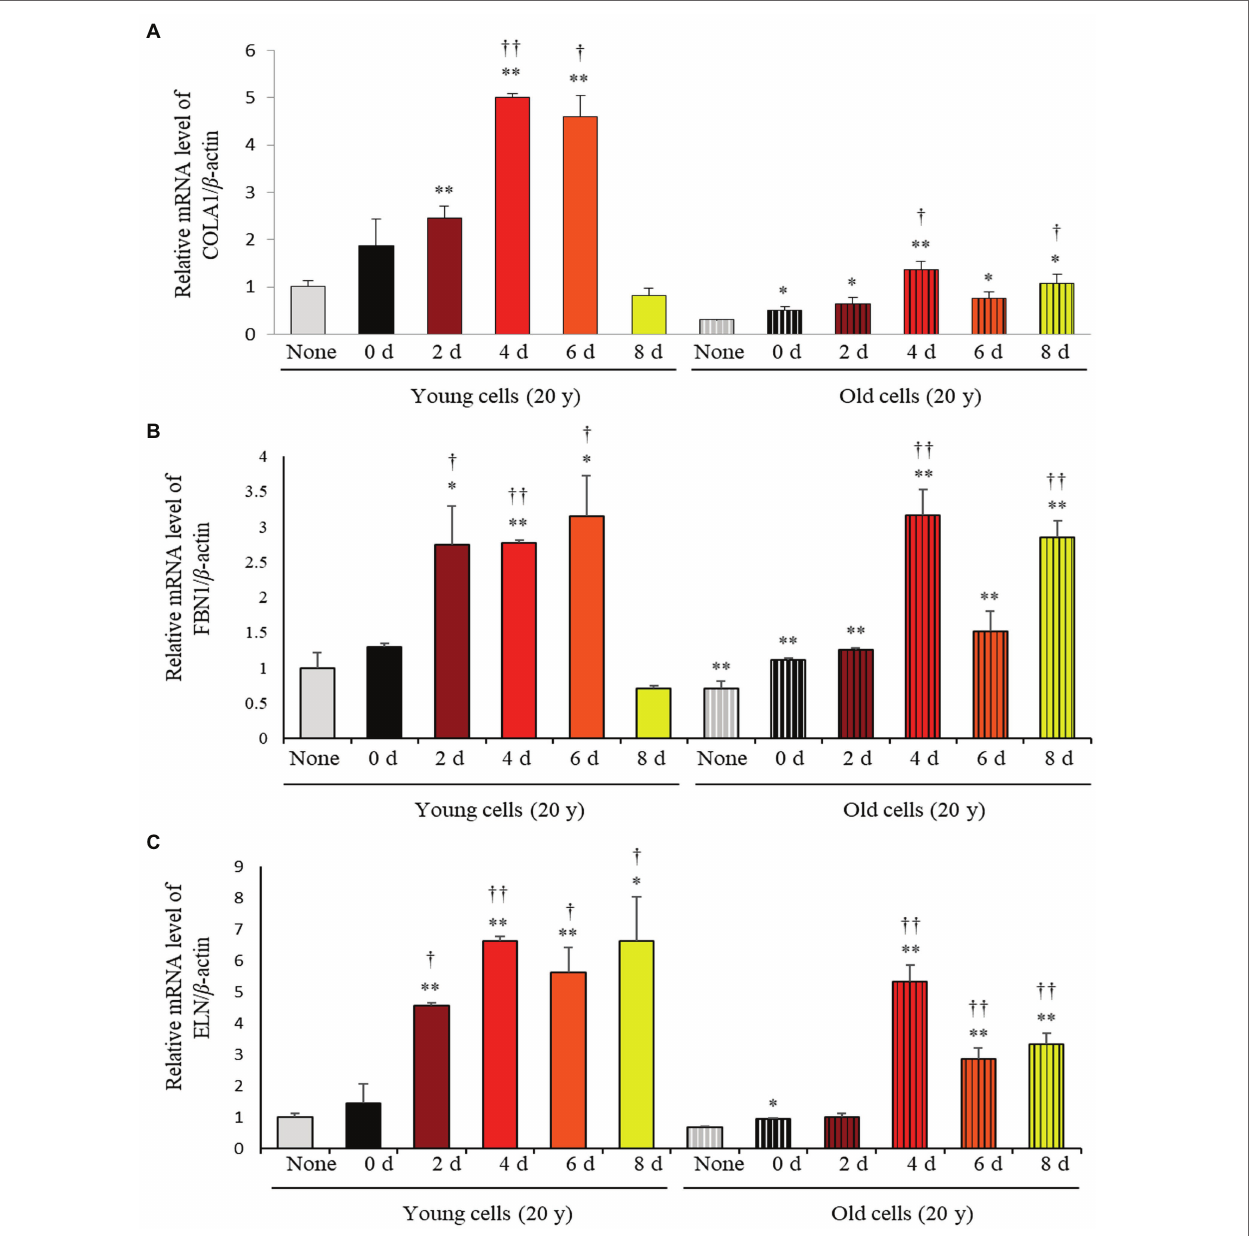
FIGURE 3 | Relative mRNA expression levels of (A) COLA1, (B) FBN1, and (C) ELN in primary normal human dermal fibroblasts (HDFS) incubated with P. notoginseng during SSF fermentation. * p < 0.05, ** p < 0.01 vs. None (Young & old), † p < 0.05, †† p < 0.0 vs. SSF-P day (young &